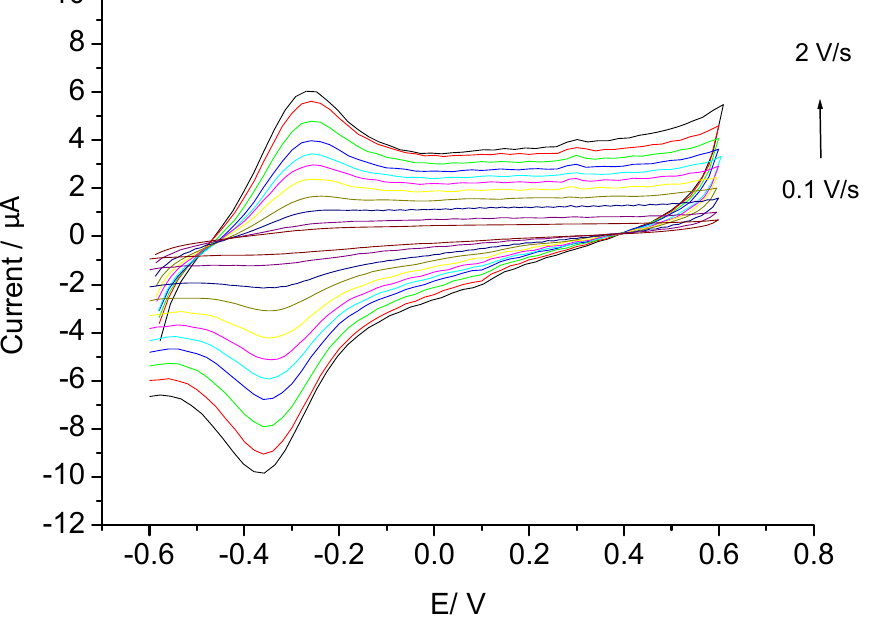
Figure 2. Cyclic voltammograms of Hemin-AuNP-CH/GCE at different scan